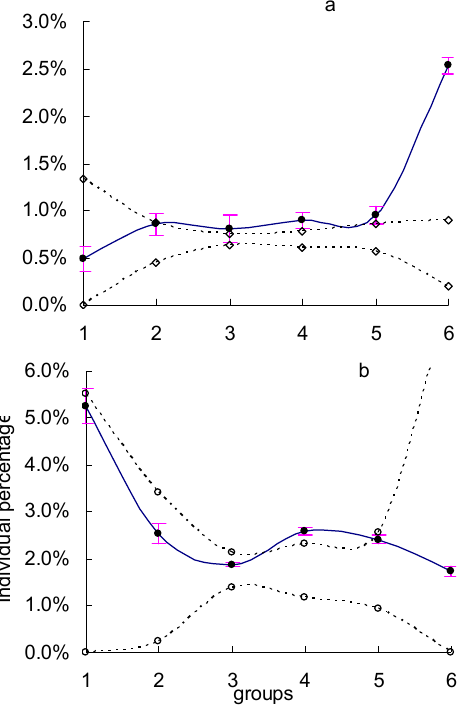
Figure 4. Distribution of neighbor trees within a 20 m radius to Castanopsis chinensis based on phylogenetic distance (six ordinal groups) in succession forest ( a ), and mature forest ( b ). Horizontal axis is group number representing increasing phylogenetic distance of neighbors to C. chinensis , while the vertical axis represents percent of neighbors within that group. Dashed lines represent the upper (97.5%) and lower (2.5%) confidence envelope for a null (neutral) hypothesis, while the solid blue line represents observed distributions for each of the six phylogenetic groups, the purple line represents the standard error.